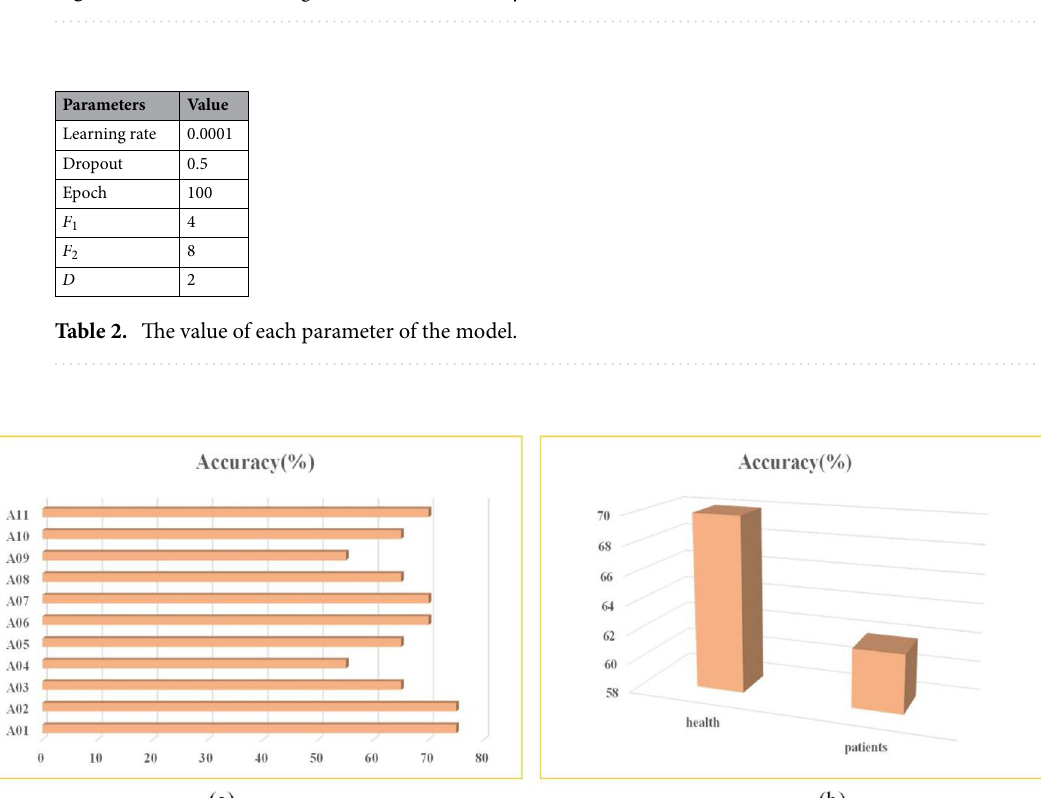
Figure 3. The overall average classification accuracy of all models.